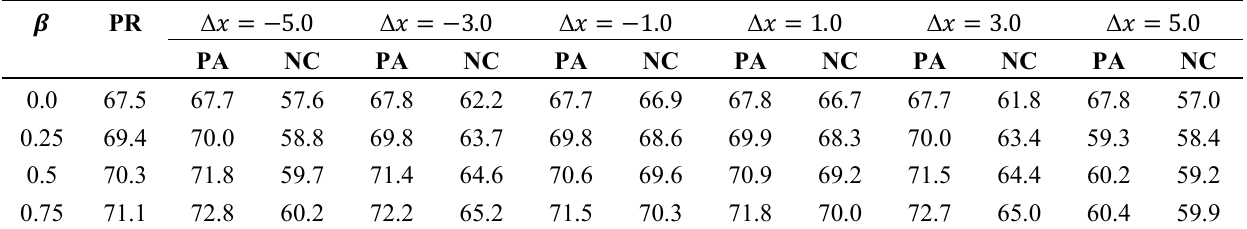
Table 11. Overall accuracies for different values of β in two extreme cases and our proposed algorithm for different initial displacement error in the x -direction Δ(cid:1876) where PA and NC denote the cases of the proposed algorithm and no registration error correction, respectively.